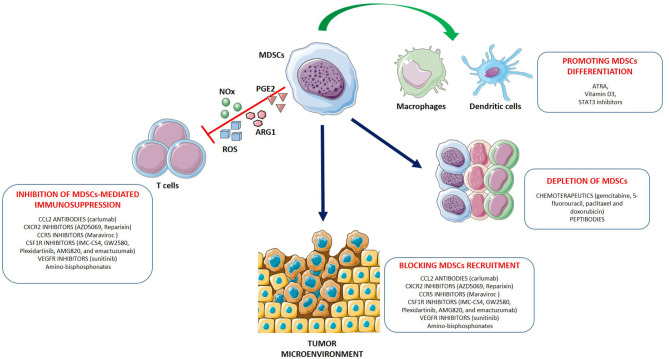
Strategies for myeloid-derived suppressor cells (MDSC) targeting. The main approaches to target MDSCs include: (1) depleting MDSC populations; (2) preventing MDSC recruitment and migration to the TME; (3) attenuating the immunosuppressive mechanisms of MDSCs by downregulating the expression of ARG1, iNOS, COX-2 and reducing ROS generation; (4) promoting the differentiation of MDSCs into mature non-suppressive myeloid cells like macrophages and dendritic cells. Examples for each therapeutic approach are shown.